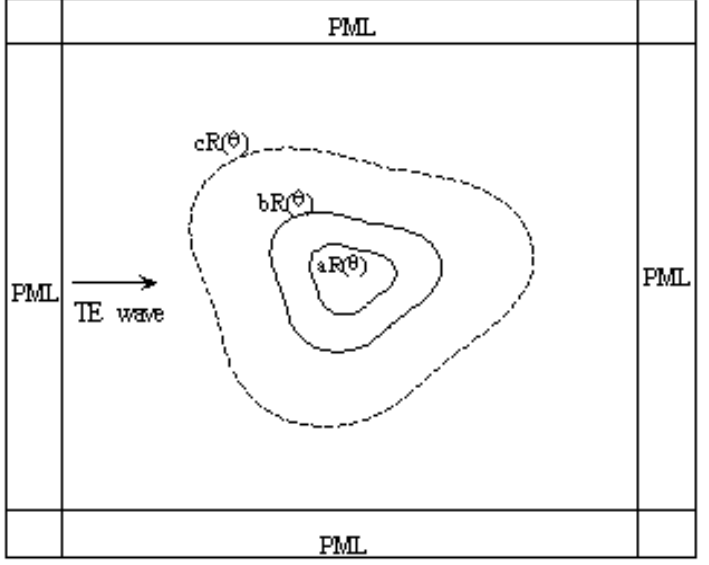
Figure 1. Computational domain of the superabsorber with arbitrary